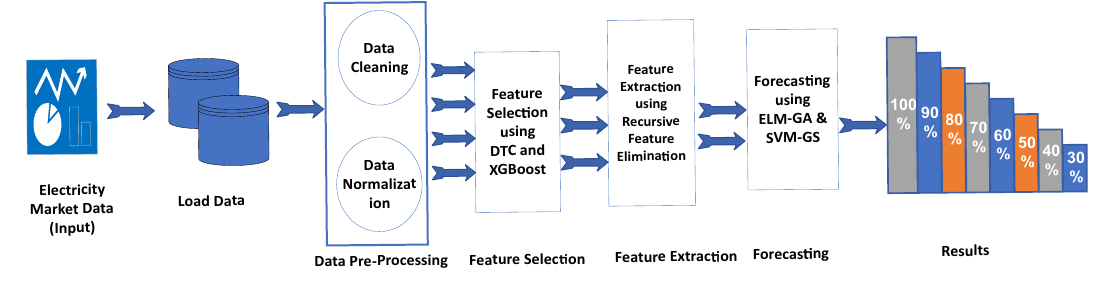
Figure 5. Proposed